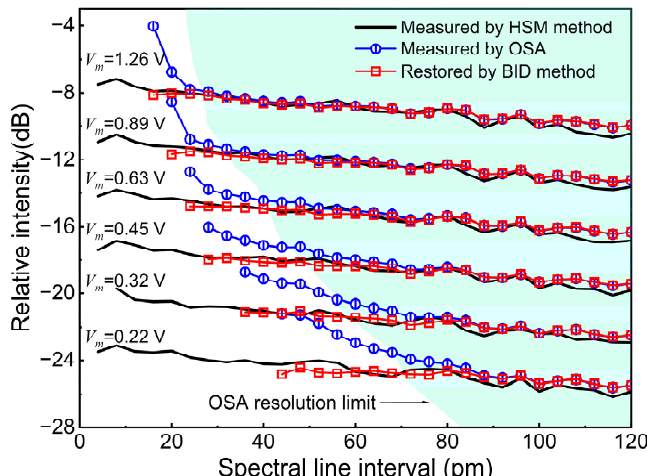
Figure 8. Relative intensity of the first-order sideband with respect to the carrier of the intrinsic modulation spectral